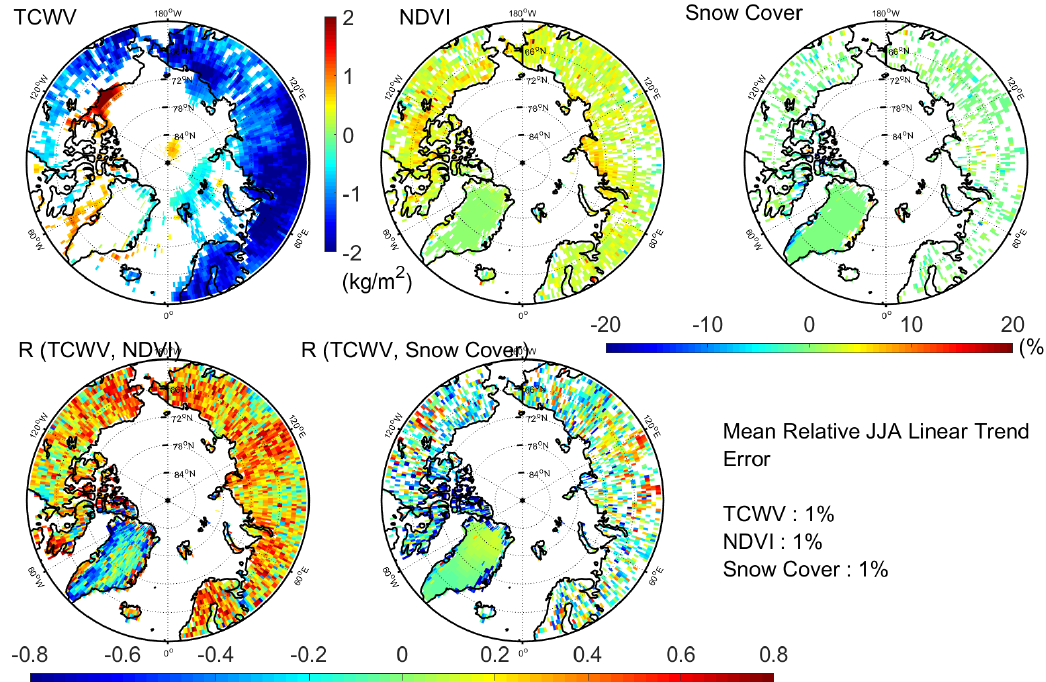
Figure 5. Upper plots: Absolute trends in JJA of TCWV, NDVI, and snow cover from left to right, respectively. Lower plots: Correlation coefficients in JJA of ( left ) TCWV with NDVI and ( right ) TCWV with snow cover for the whole 15 years of data. Note that TCWV trends are in kg/m 2 /decade, and NDVI and snow cover use the same colour bar ( bottom ); their trends are in %/decade. Both correlation maps use the colour bar at the bottom. Only statistically significant trends at the 95% confidence level based on a Student’s t test are shown. Pixels with missing data or not significant trends at the 95% confidence level are in white.